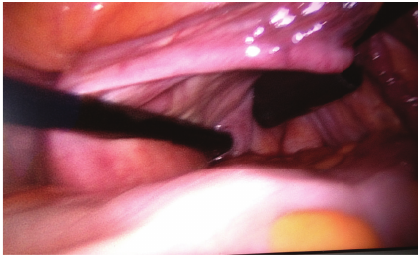
Figure 1: Transvaginal 12mm trocar and a separate 5 mm grasper (without trocar) placement under laparoscopic guidance. View of posterior fornix.